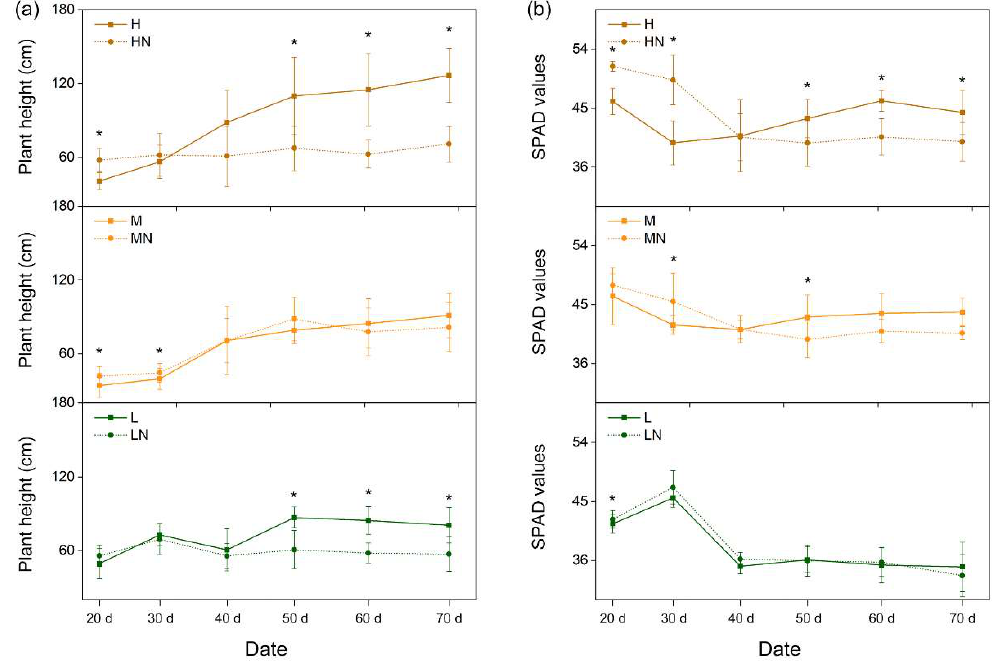
Figure 4. Plant height ( a ) and leaf SPAD values ( b ) of P. australis during experimental periods. *Indicates a significant difference between the plots without N addition and with N addition in terms of soil characteristics under the same soil salinity level in the same determination period ( p < 0.05). Table 4. Results of multiple-way ANOVA on the effects of salinity (S), N addition (N), growth stage (G), and soil depth (D) and their interactions on growth indices of P. australis .